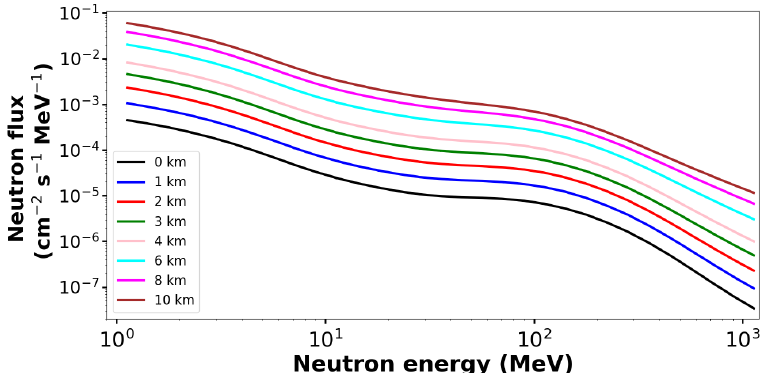
Figure 1. Atmospheric neutron spectra for various altitudes at geographical points with a latitude of 0 ◦ and a longitude of 0 ◦ . See text for more